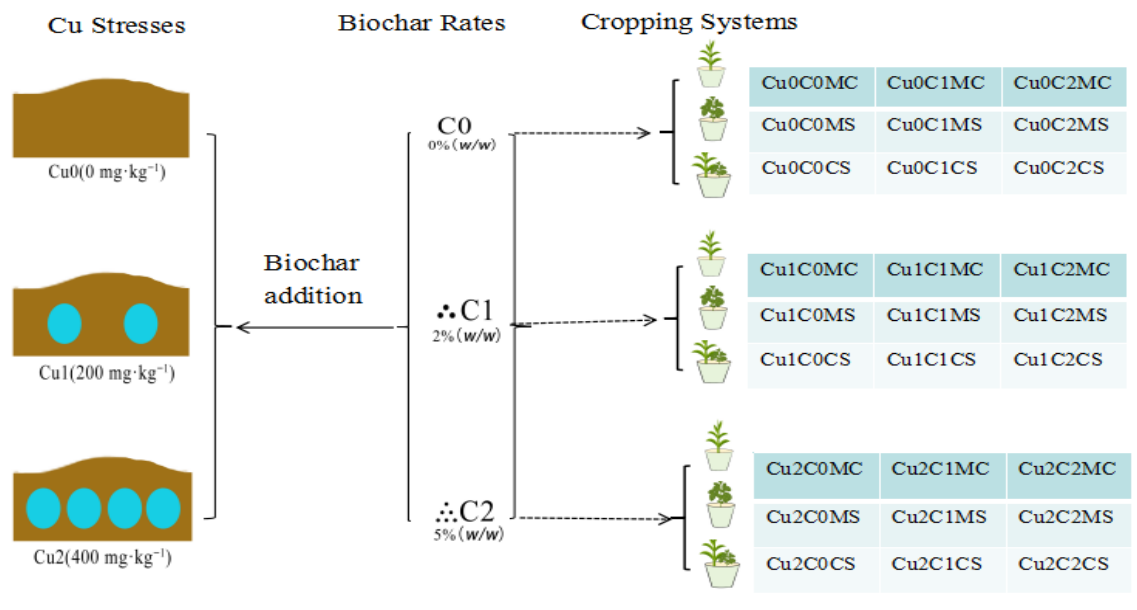
Figure 5. Experimental design and description of treatments. Note: represents monocropped sweet corn (MC), represents monocropped soybean (MS), represents sweet corn–soy- bean intercropping (CS).